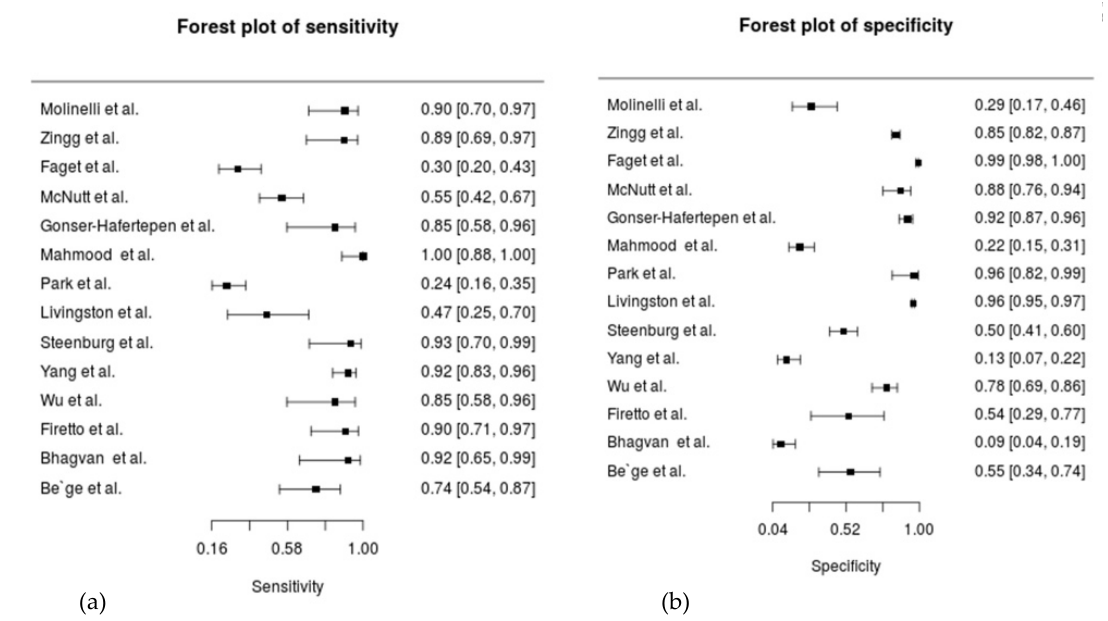
Figure 2. The forest plot of included studies; ( a ) the forest plot of sensitivity of 14 studies; ( b ) the forest plot of sensitivity of 14 studies.